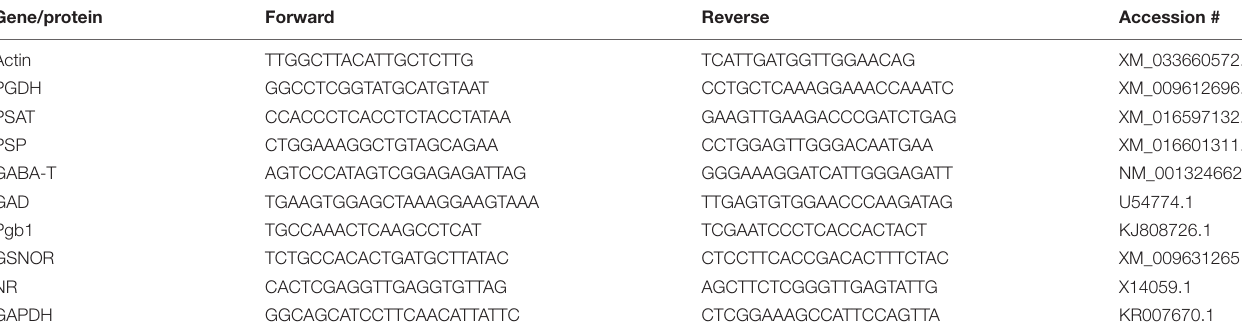
TABLE 1 | Primers used for qRT-PCR.